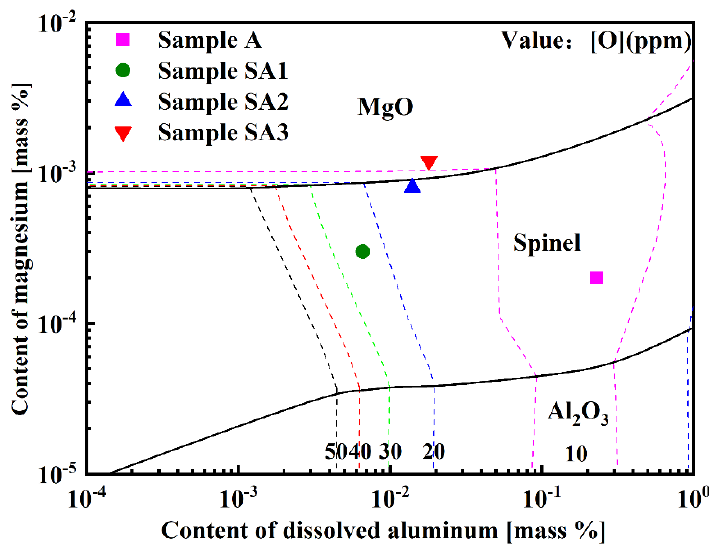
Figure 13. Al-Mg stable phase diagram of 15-5PH stainless steel at 1600 °C .